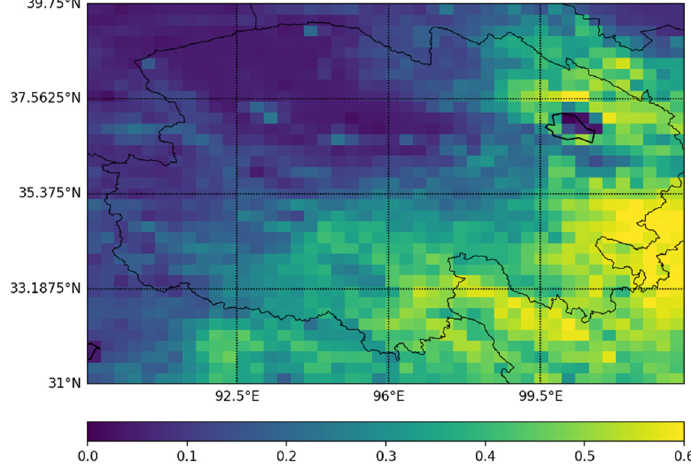
Figure 1. The enhanced vegetation index (EVI) in the study area of Qinghai Province, China, based on the MYD13A3 MODIS satellite data product (2017).